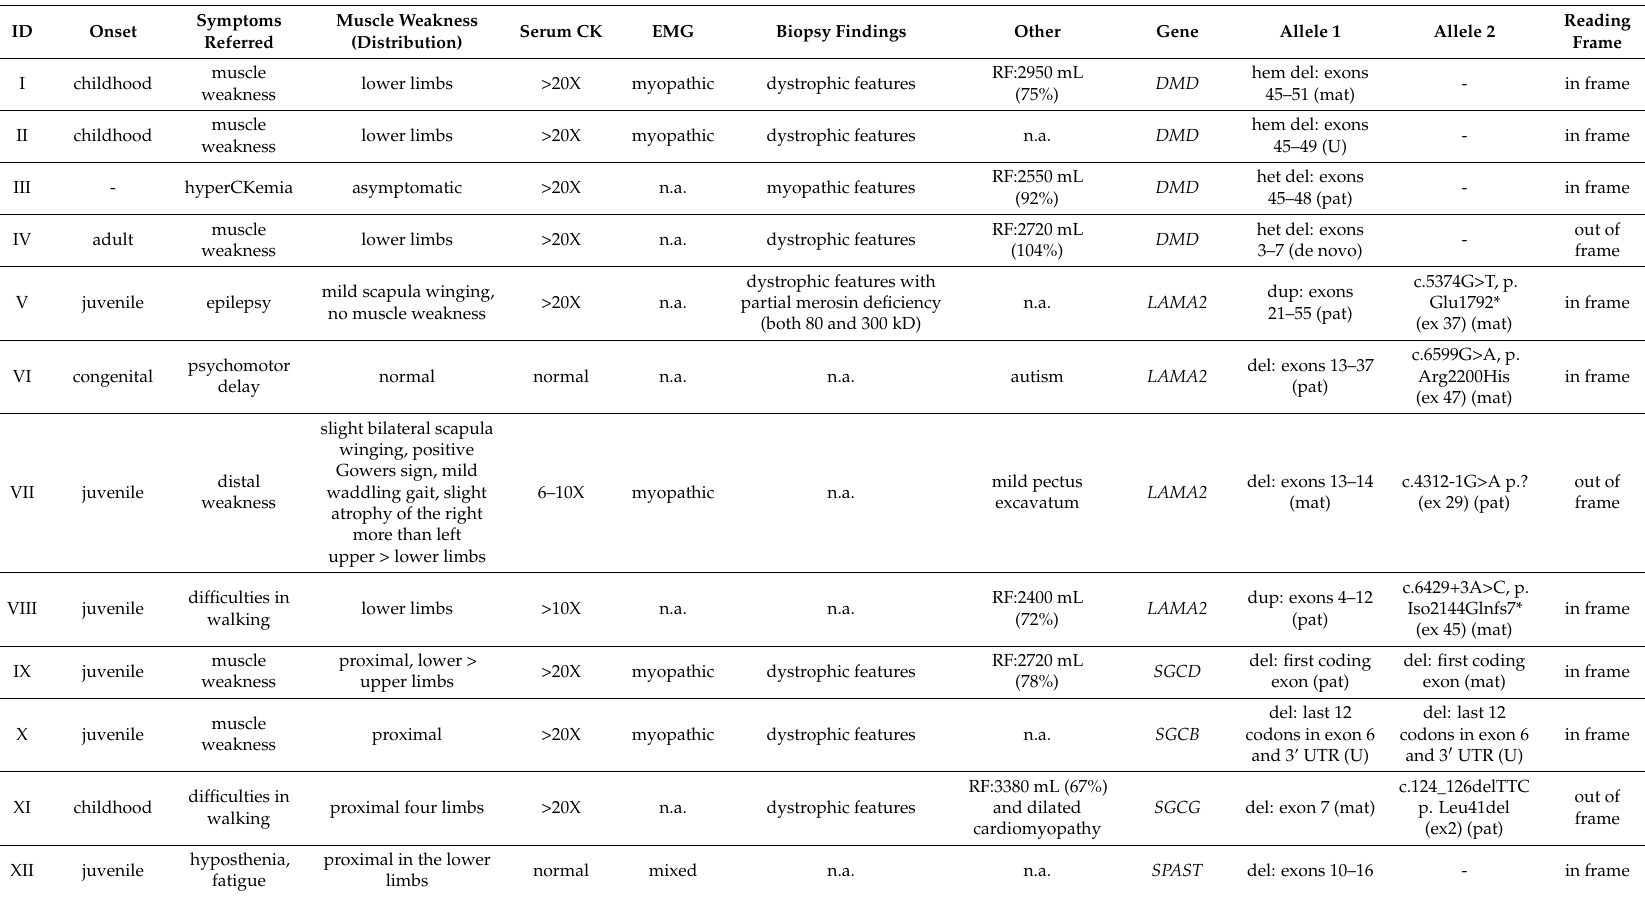
Table 1. Causative copy number